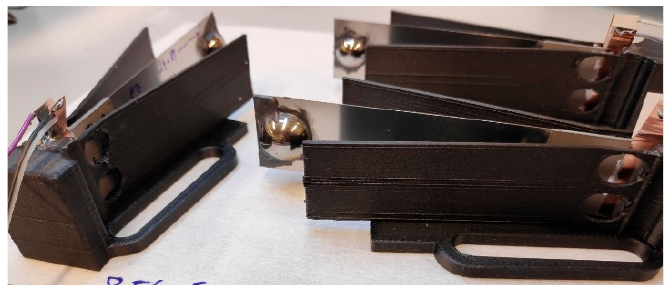
Figure 2. Prototype cantilevers clamped into nylon-reinforced 3D-printed holsters.